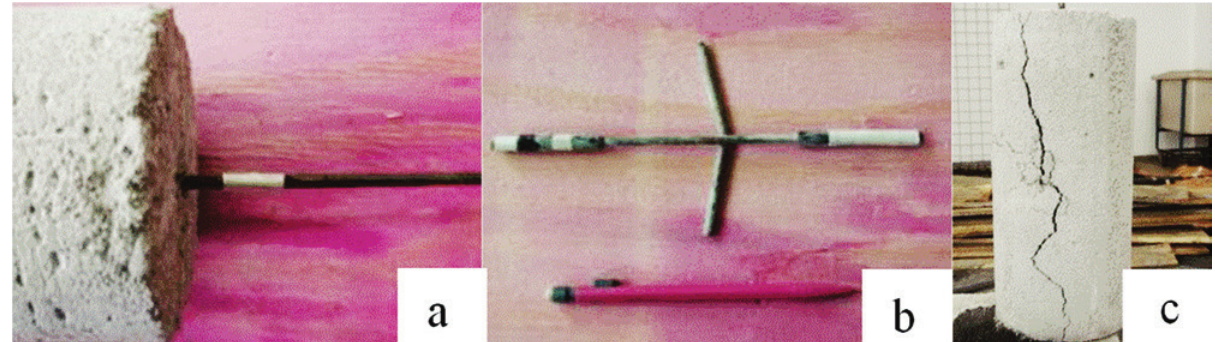
Nota: deslizamento da barra longitudinal com dobramento da barra transversal (a, b) provocando a fissuração longitudinal e transversal do cilindro de concreto Figura 9 Modo de ruptura da amostra AT3